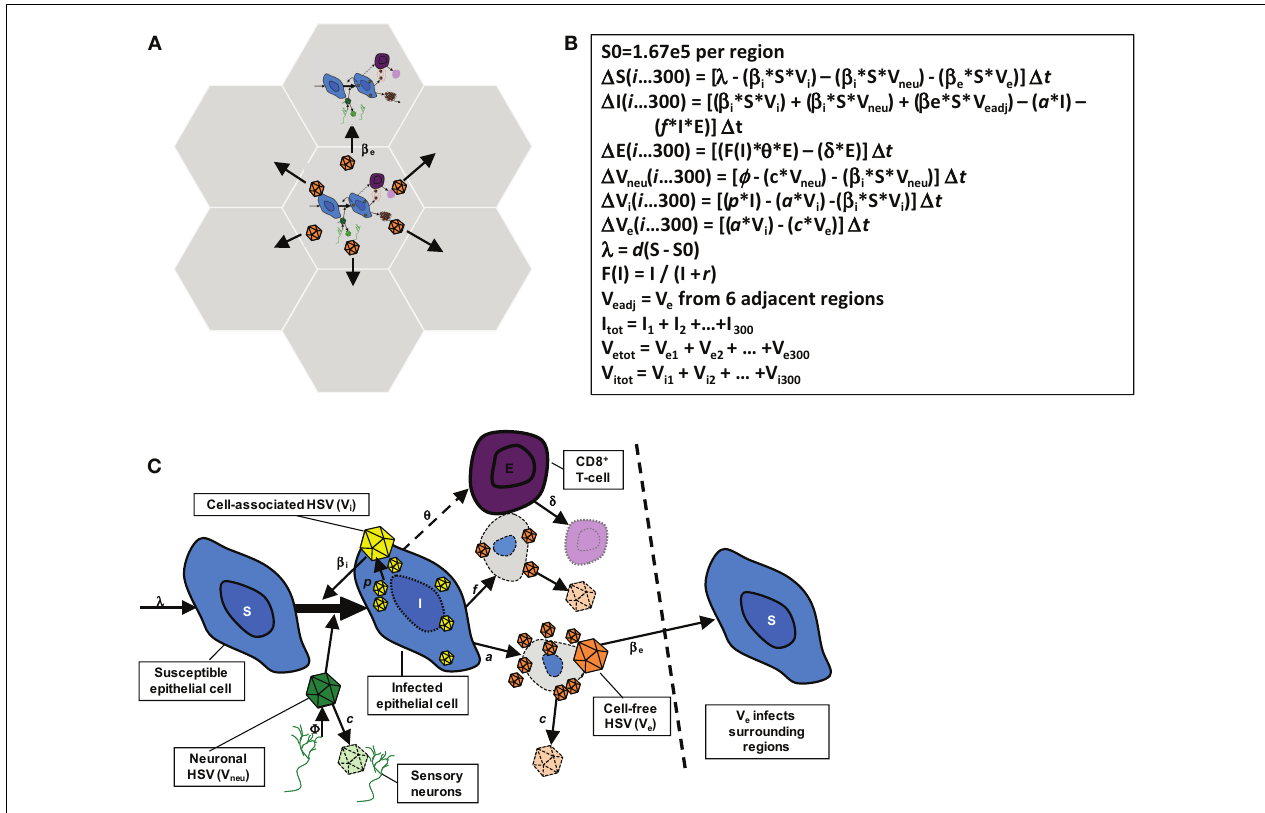
FIGURE 2 | Spatial mathematical model . (A) Seven of 300 micro-regions are shown to indicate that cell-free virus from a single region can infect adjacent regions. (B) Model equations. (C) Model diagram indicating viral production, spread, and local CD8 + T-cell response: from Schiffer et al., eLife 2013;2:e00288.